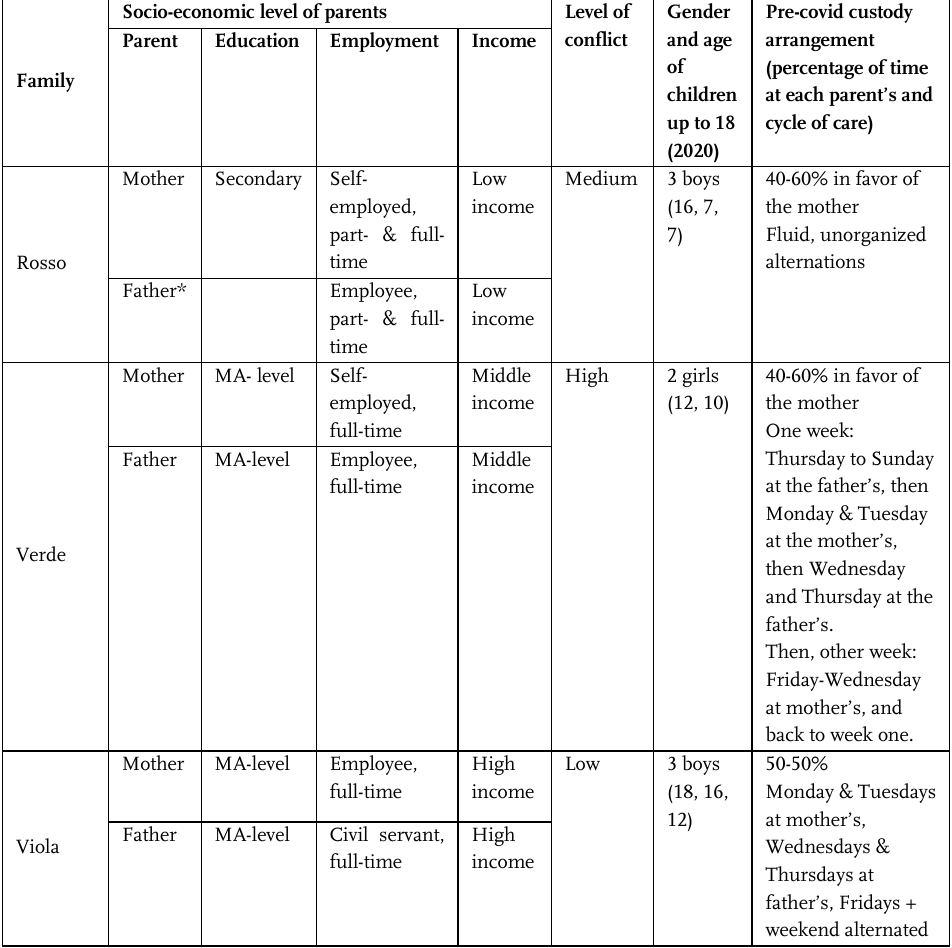
Table 1: Family profiles and custody arrangements before Lockdown (continued)